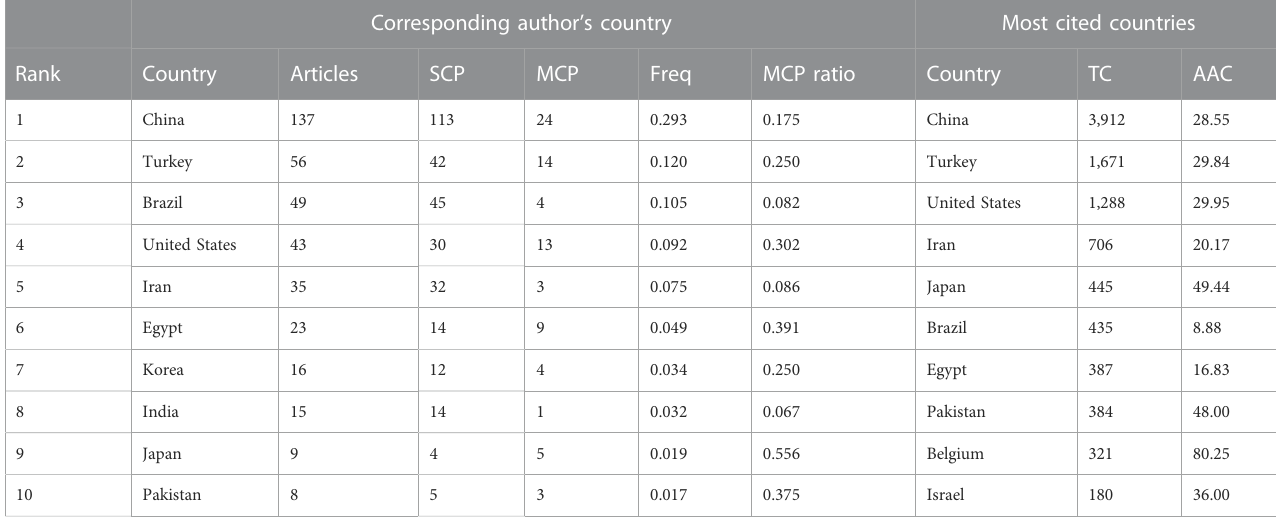
TABLE 2 Top 10 productive countries contributing to research on heat stress in